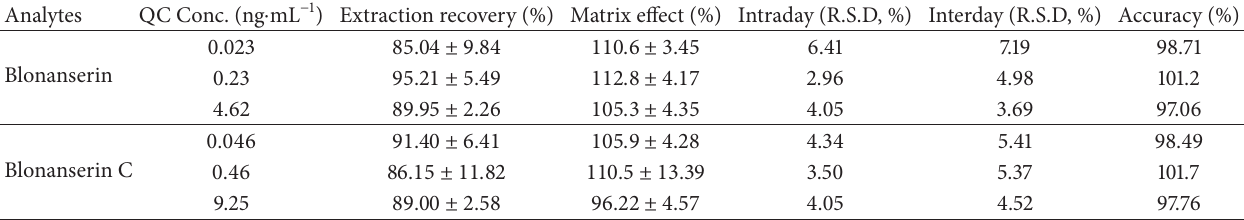
Table 2: Extraction recovery, matrix effect, precision, and accuracy of the developed method ( 𝑛 = 6 ).